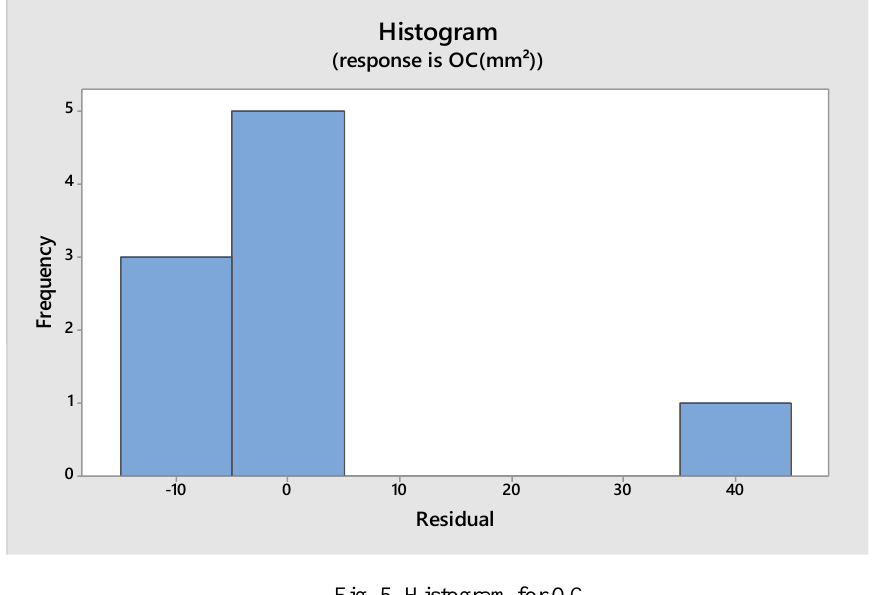
Fig. 5. Histogram for OC